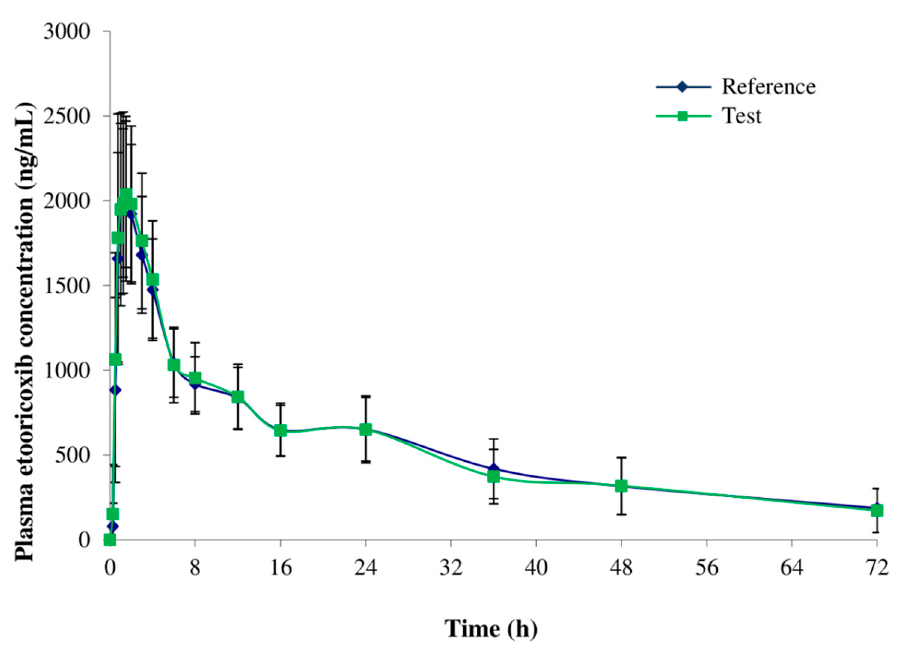
Figure 4. The mean plasma etoricoxib concentration–time profiles of test and reference products of etoricoxib 120 mg. Table 6. Pharmacokinetic data of test and reference products in healthy volunteers after single dose of 120 mg of etoricoxib under fasting conditions (mean ± SD, n = 18).